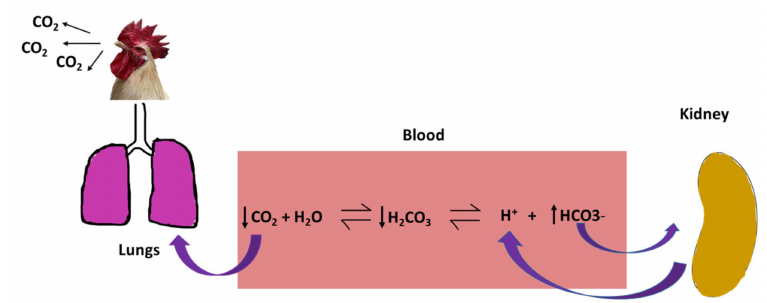
Figure 3. Schematic diagram showing an acid-base imbalance in poultry under heat